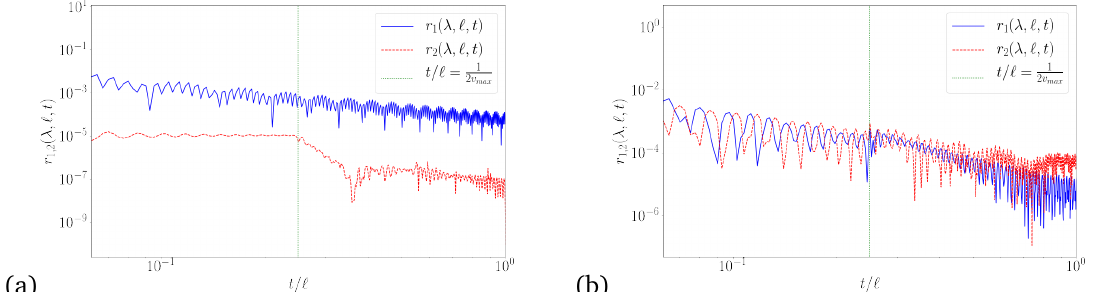
( λ = 0.1, (cid:96) = 200, t ) for a quench within the para- 1,2 = 5 to h = 1.5. (b) same for r 0